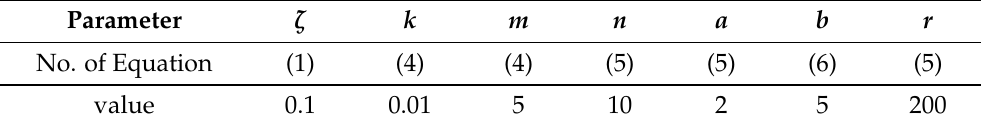
Table 1. Key parameters of the IVPF